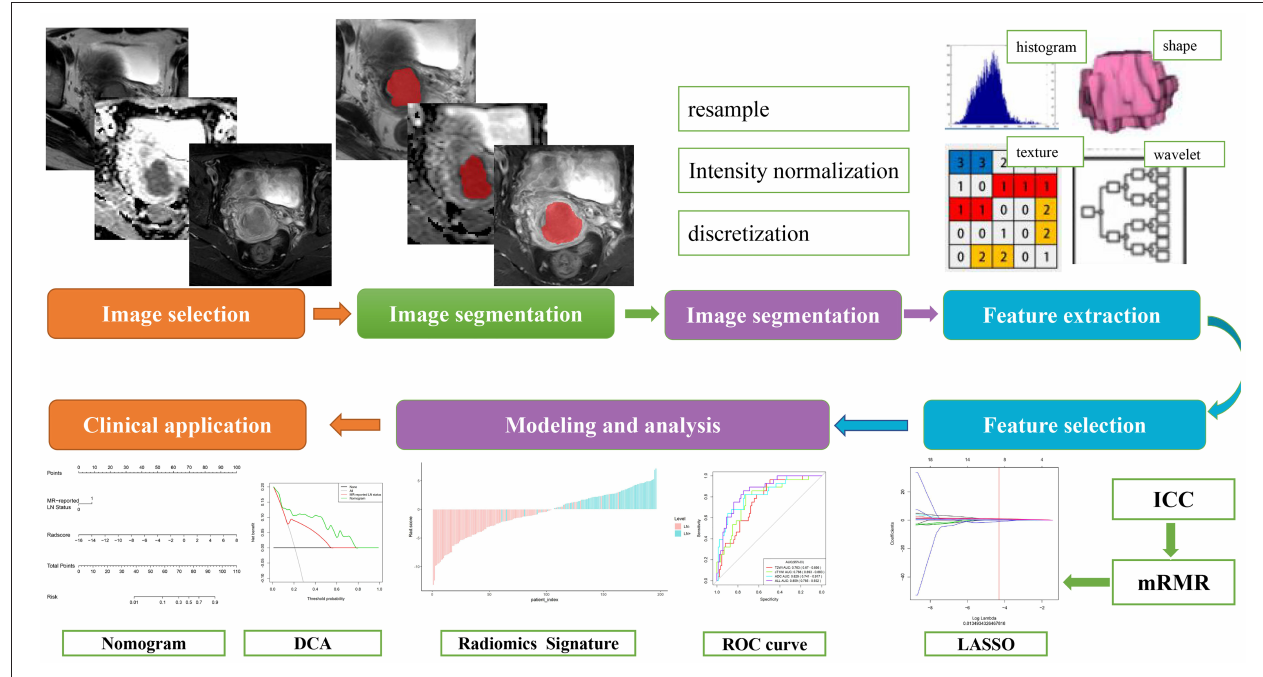
FIGURE 1 | The workflow of radiomic analysis in the current